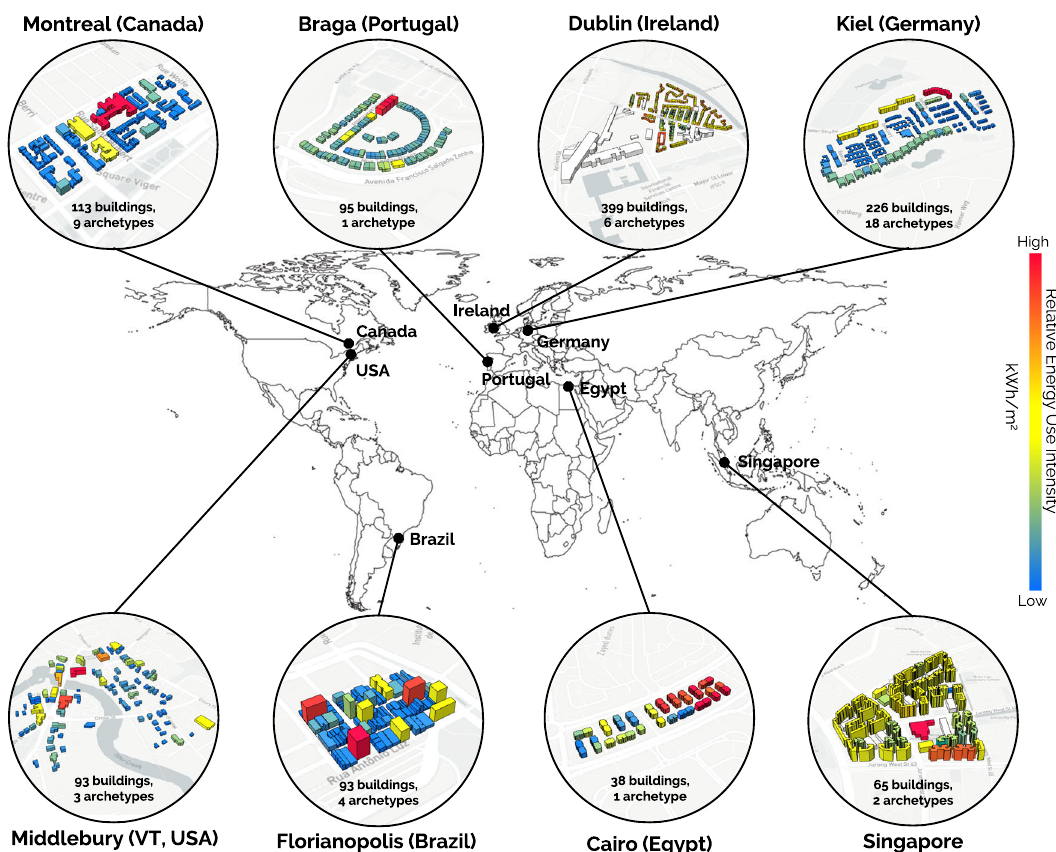
Fig.1|Baselineurbanbuildingenergymodelsfortheeightcities. Thecolourof each building indicates the relative energy use intensity compared to other buildingsinthemodel.Forexample,inSingaporewithtwoarchetypesde fi ned(viz. residential and commercial),weobserve thatthe commercialbuilding (in red)has